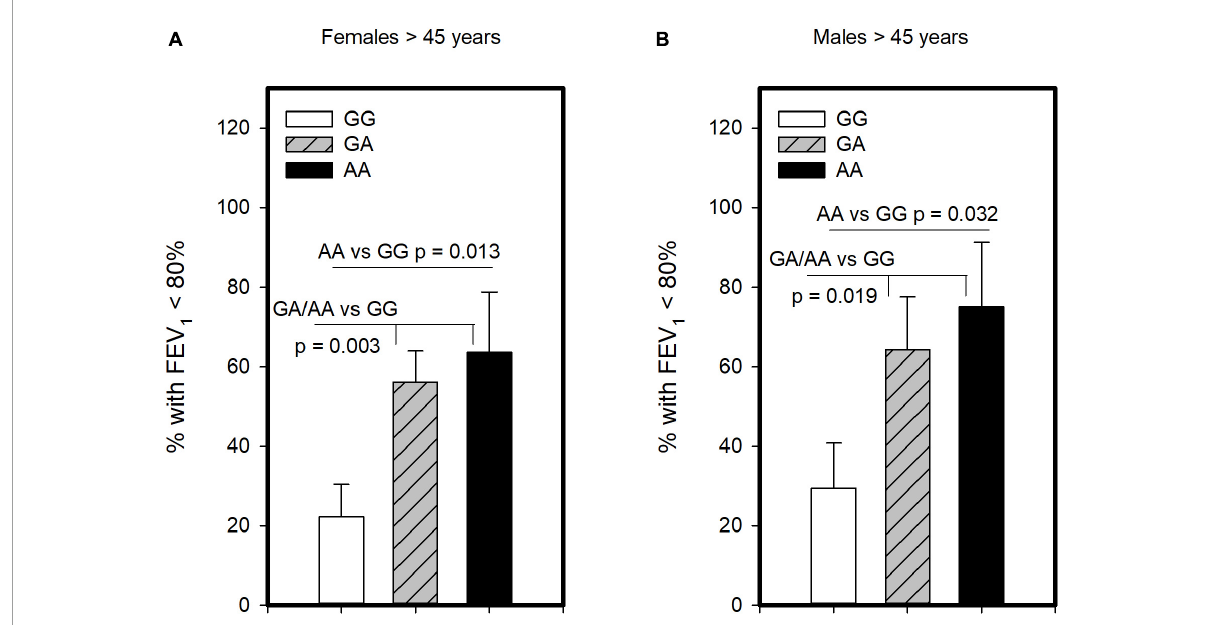
FIGURE3 The CRTh2 rs533116 G > A polymorphism is associated with lung function. Asthmatics were genotyped and assessed for the likelihood of having